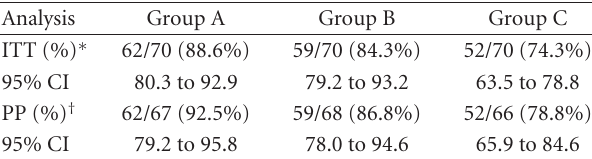
Table 2: Helicobacter pylori eradication rates with sequential and standard therapy both at intention-to-treat (ITT) and per protocol (PP)